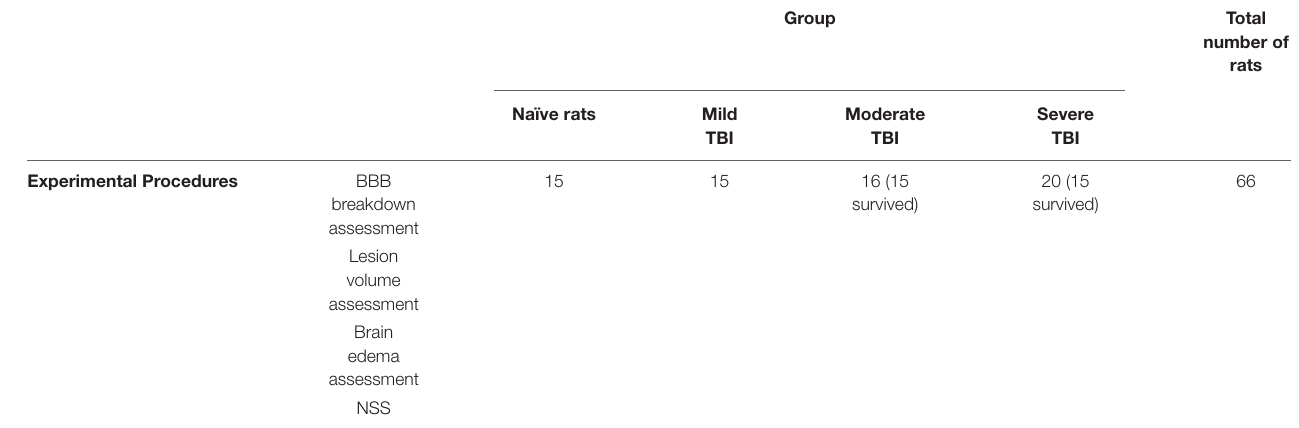
TABLE 1 | Experimental procedure.